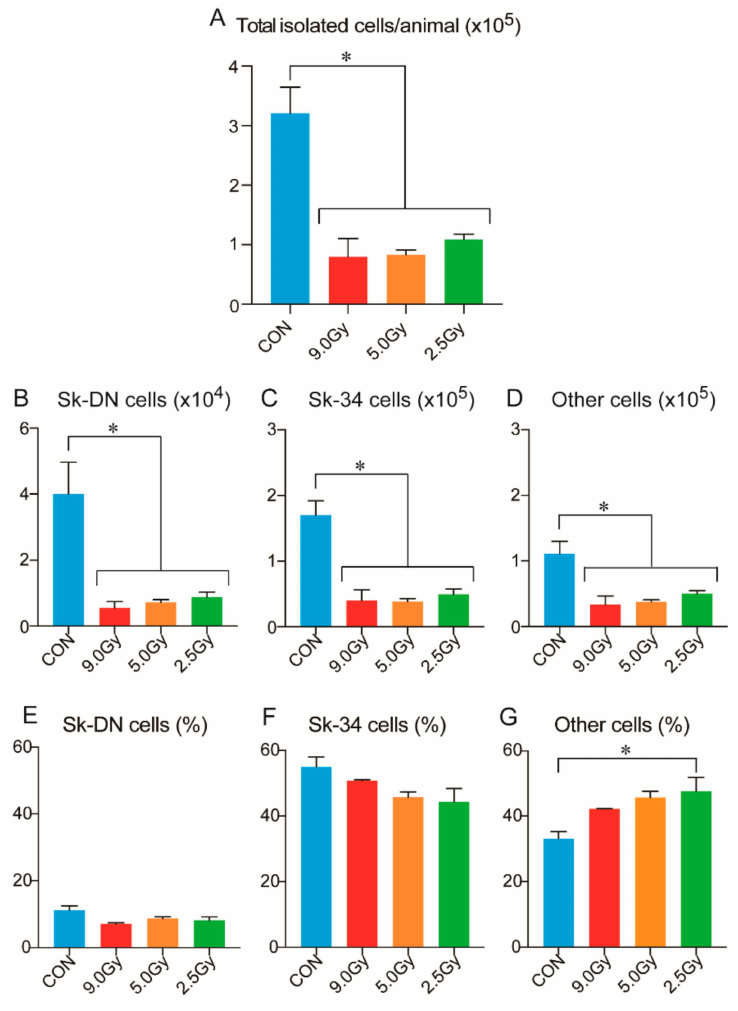
Figure 3. The number of enzymatically isolated cells and Sk-DN, Sk-34 and other cells. All values were normalized per one animal. Both sides of the TA, EDL, GAS, SOL, PLT and QF muscles were consistently used. ( A ) Absolute value of isolated live cells. ( B ) Absolute value of Sk-DN cells. ( C ) Absolute value of Sk-34 cells. ( D ) Absolute value of other cells. ( E ) Percentage of Sk-DN cells. ( F ) Percentage of Sk-34 cells. ( G ) Percentage of other cells. CON: normal control group. Sk-DN = CD45-/34-/29+, Sk-34 = CD45-/34+, other cells=all marker negative. Values are expressed as mean ± SE. * p <